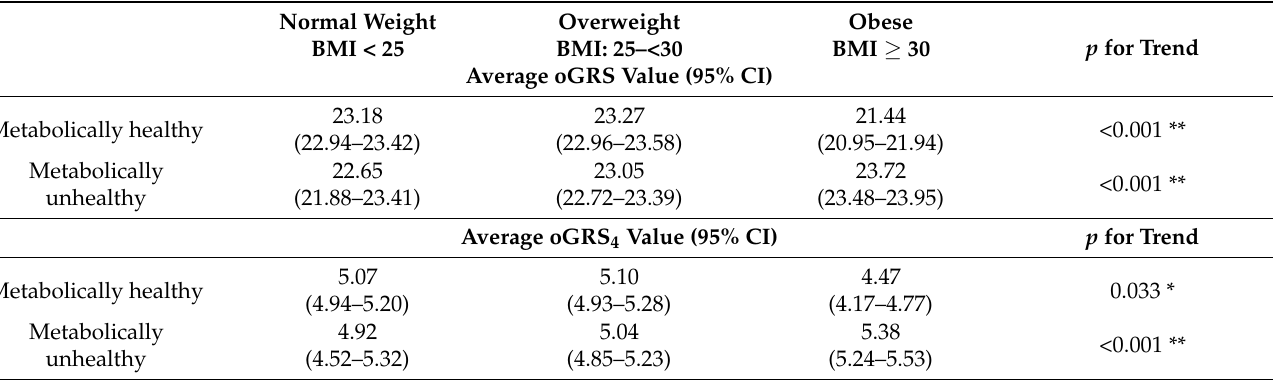
Table 2. Results of trend analyses carried out on optimized genetic risk score (oGRS) and oGRS 4 values changing by subgroups created on the basis of BMI